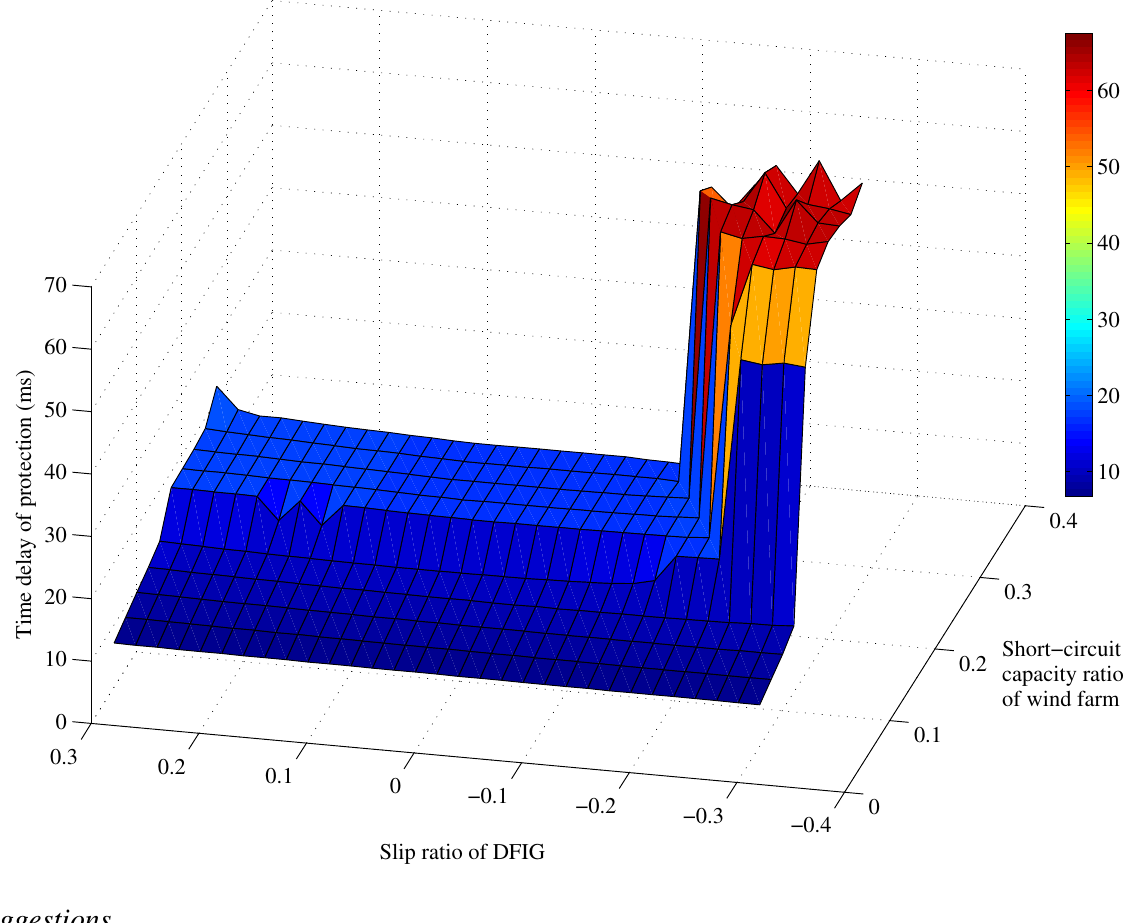
Figure 12. Time delay of protection with the setting value of K selected as